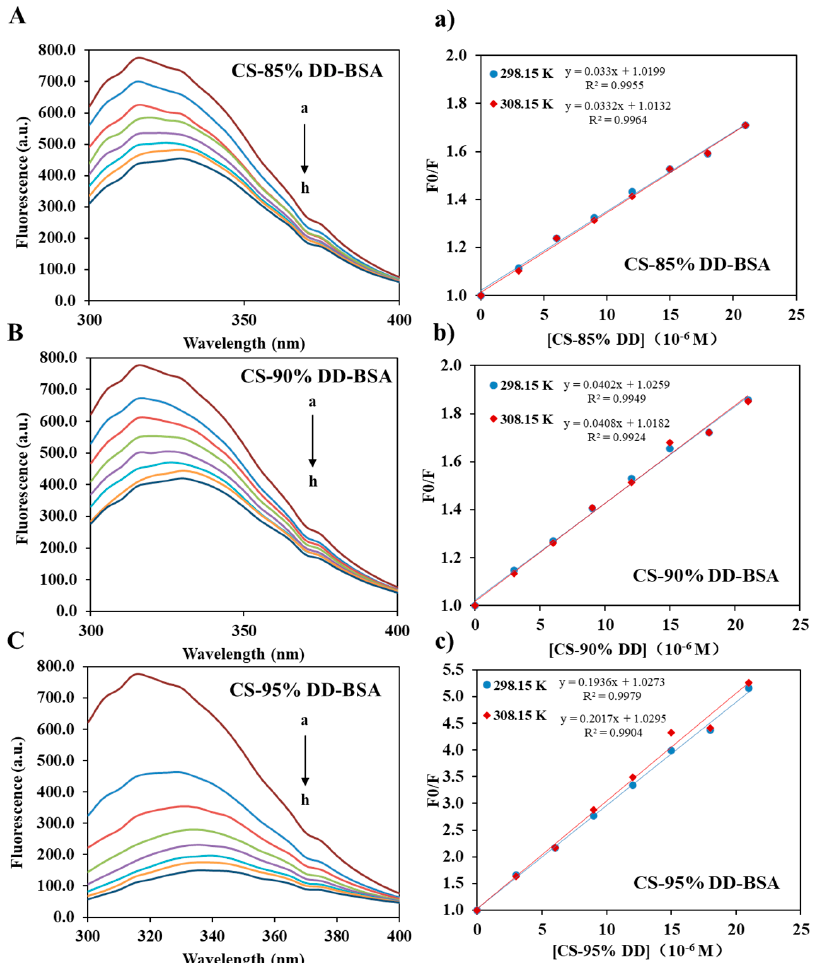
Figure 8. Steady-state fluorescence spectra of BSA in the absence and presence of CS ( A – C ) at 298.15 K, and Stern–Volmer plots ( a – c ) at 298.15 K and 308.15 K. [BSA] = 8 µ M and [CS, a–h] = 0, 3, 6, 9, 12, 15, 18, 21 µ M, λ ex = 280 nm.